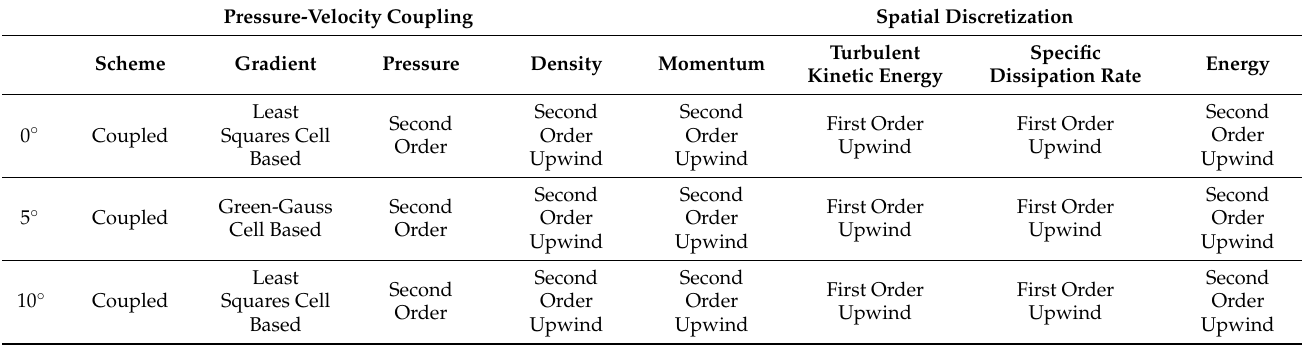
Table 3. The specific parameters of solution methods.